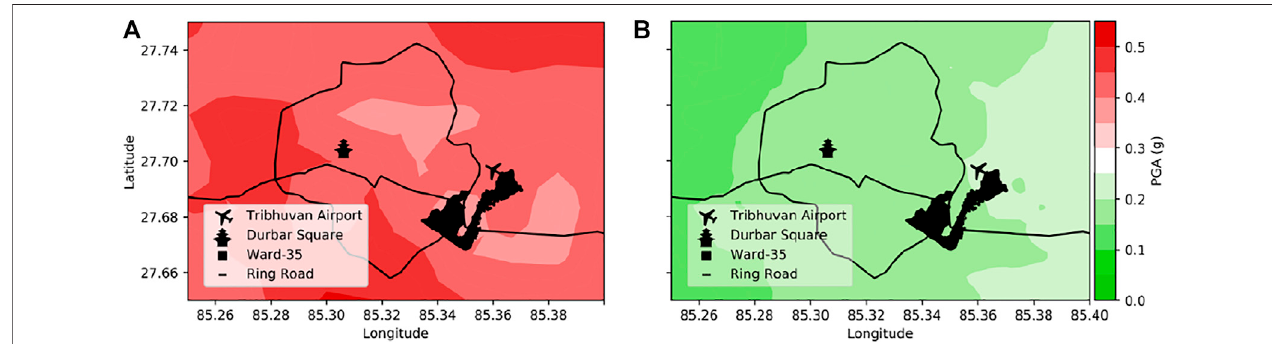
FIGURE9| PGAshake map oftheearthquakeeventoccurringon (A) April25, 2015(Mw 7.8) and (B) May 12,2015(Mw 7.3) (USGS 2018),and location ofWard- 35 buildings.